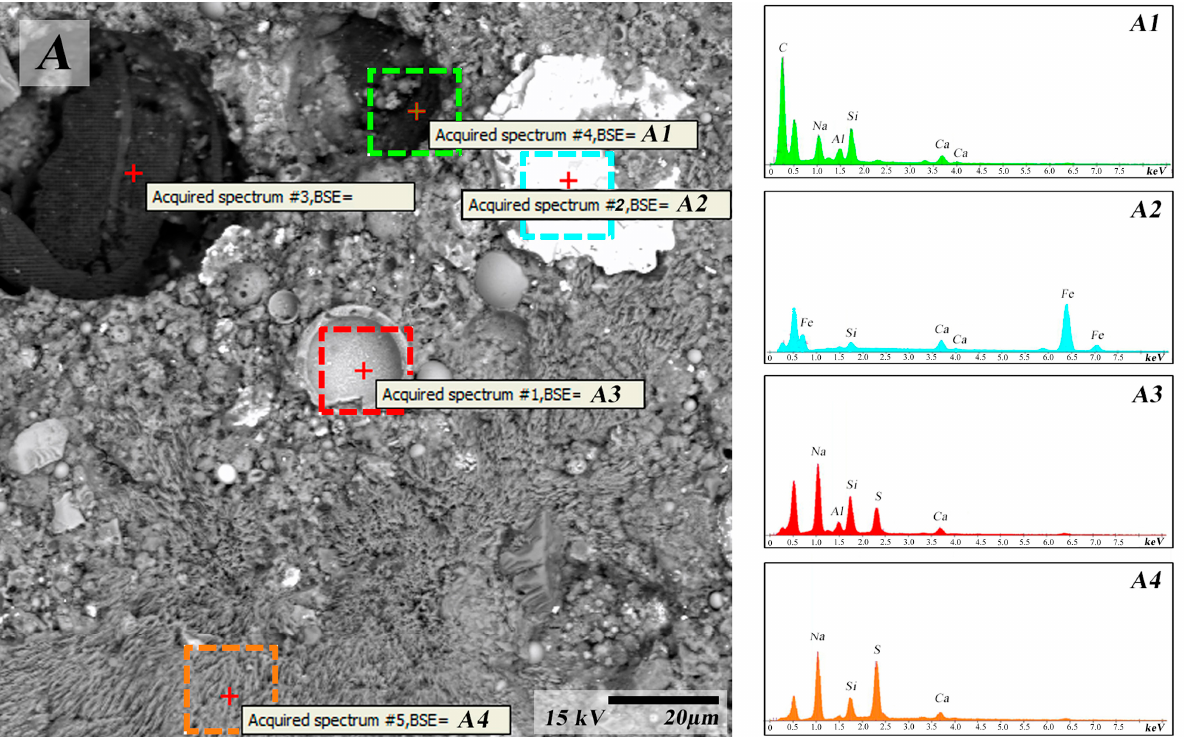
Figure 8. Selected SEM micrographs and EDS spectra of the 28-day attrition-milled fly-ash-based geopolymers.